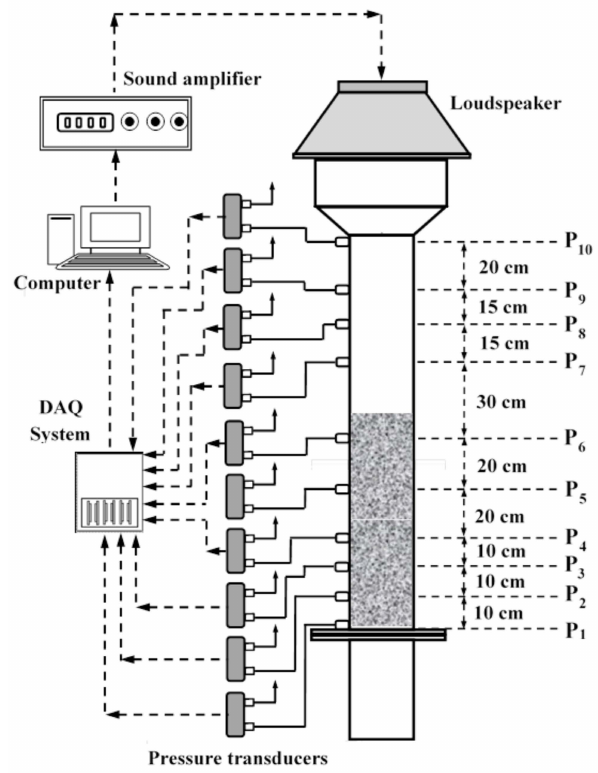
Figure 1. Schematic of the experimental set-up.